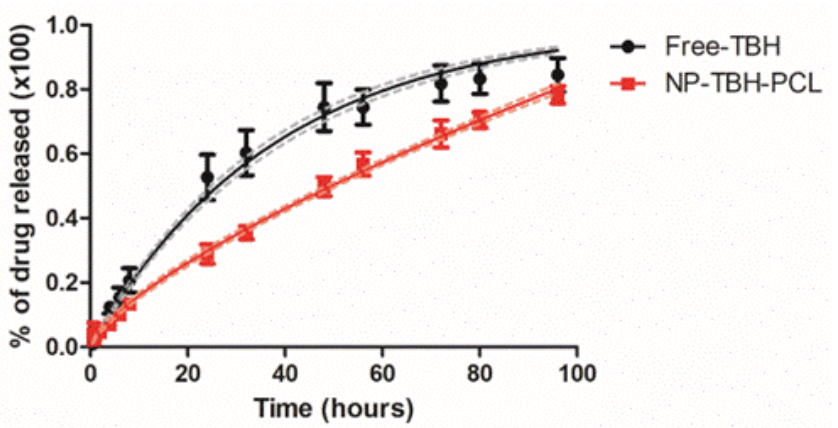
Figure 4. In vitro drug release profile of free-TBH and NP-TBH-PCL. Data is presented as average ± SD, n = 6. The continuous curves and their confidence interval (dashed lines) are the best mathematical fit. Table 3. Obtained kinetic parameters of the in vitro release profile of